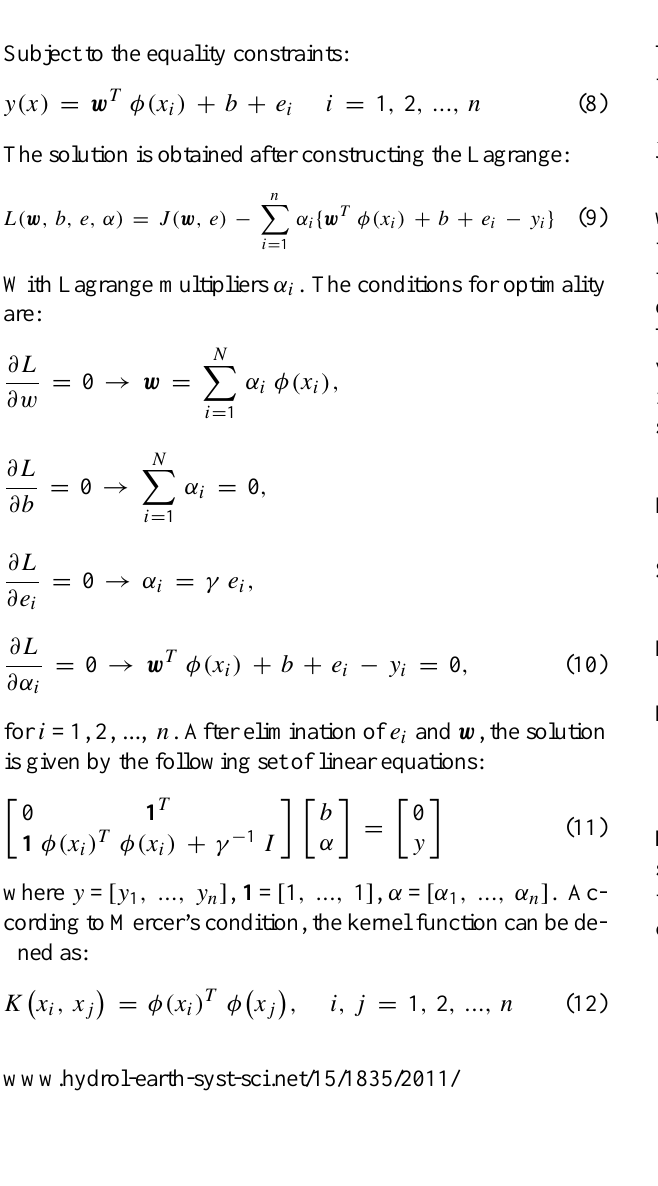
Fig. 2. Architecture of